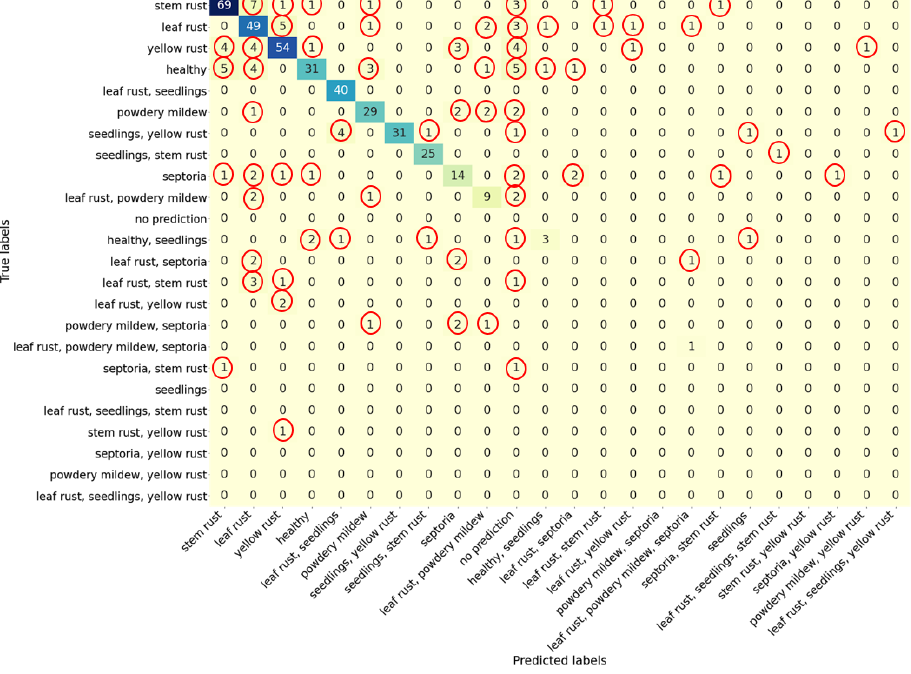
Figure 9. Confusion matrix for the test sample for the EfficientNet-B0_FDA model. Rows, true labels; columns, predicted labels. The off diagonal cells with non-zero values are highlighted by red circles.